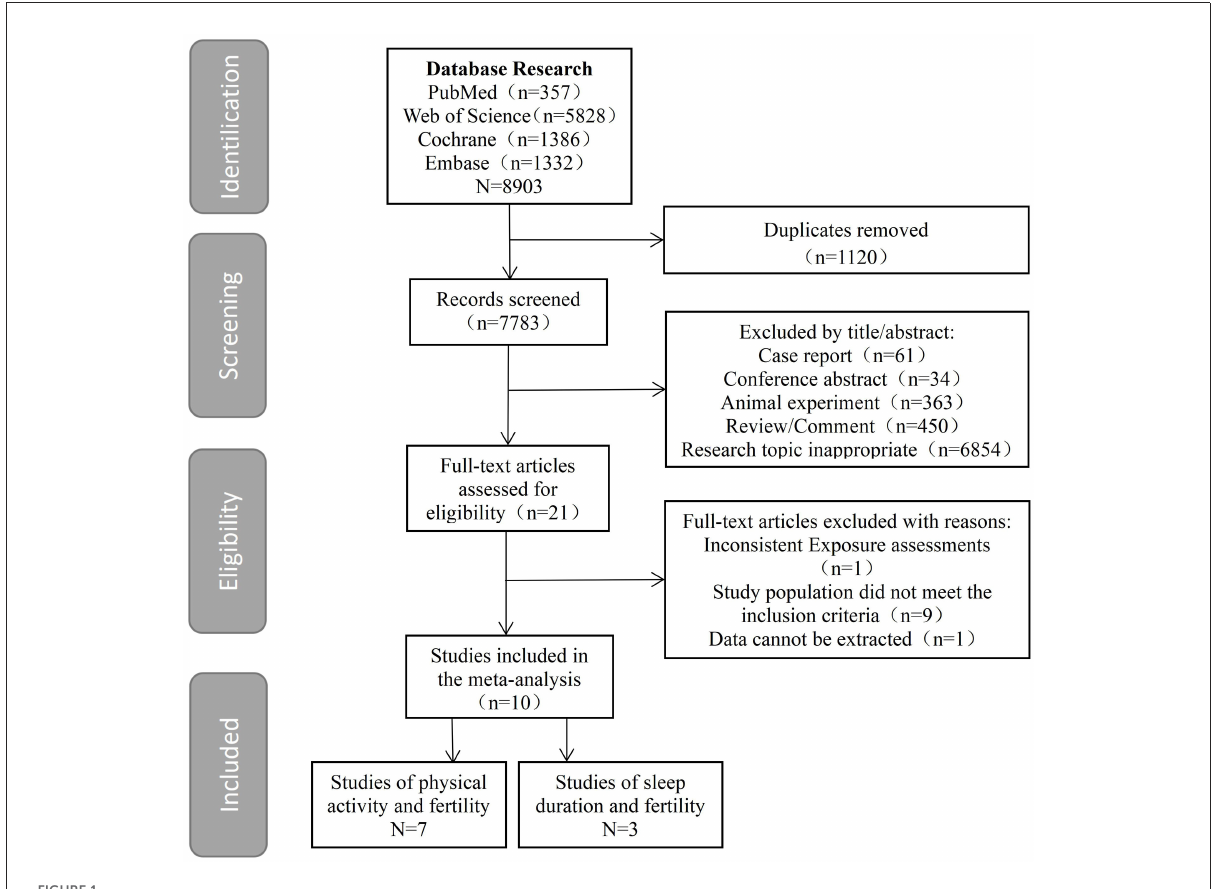
FIGURE1 Selection process for the systematic review and